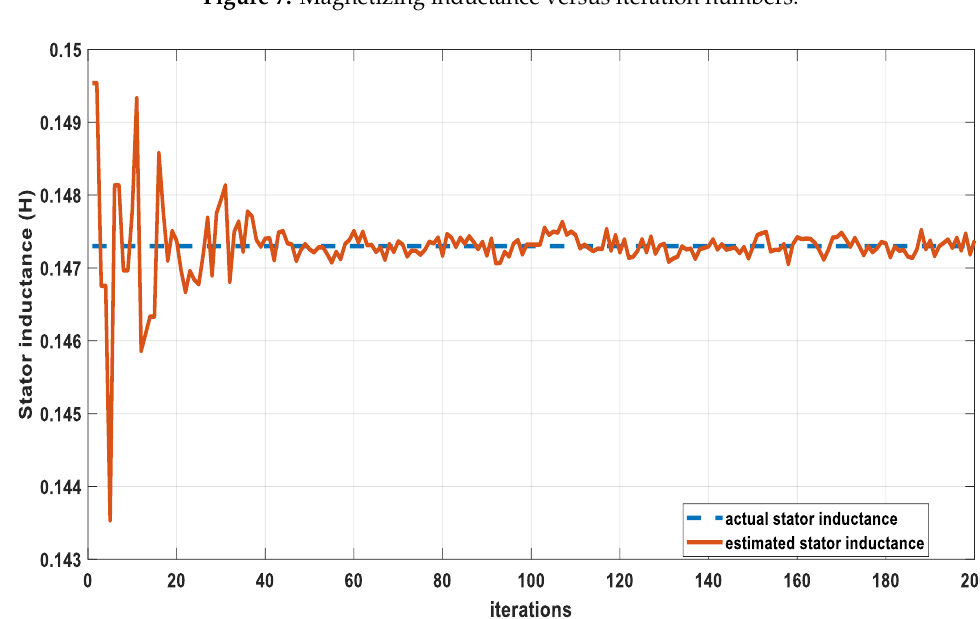
Figure 8. Stator inductance versus iteration numbers.